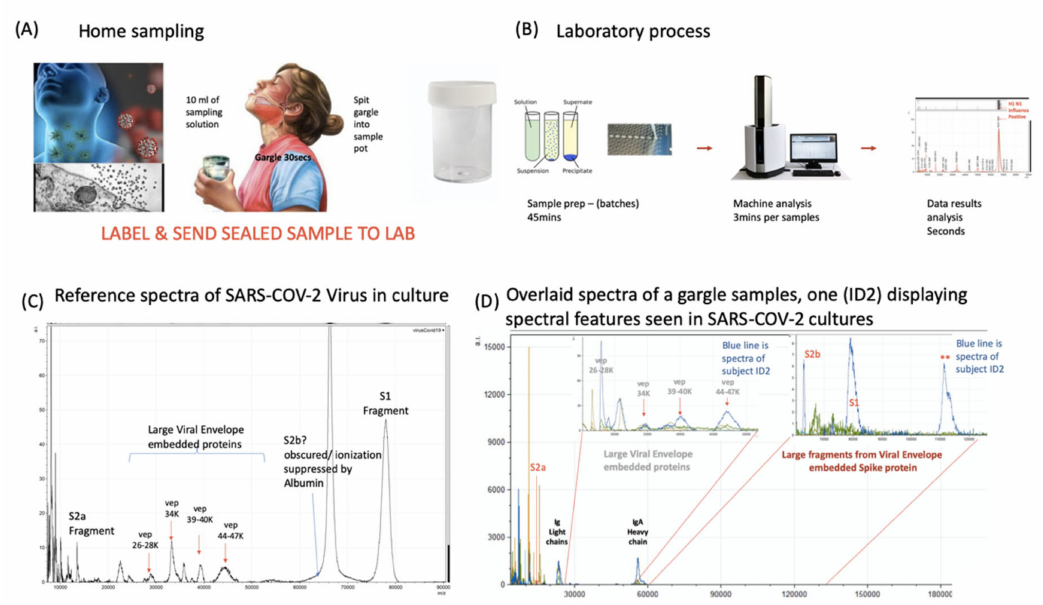
Figure 4. Clinical diagnostic protocol of gargle saliva collection, laboratory processing and spectral data features: Panel ( A ) illustrates patient (home) sampling gargling 10 mL of water and spitting that into a sample pot. Panel ( B ) illustrates rapid processing where received gargle sample is filtered through 1.2 and 0.45 mm filters, 5 mL is recovered and is acetone precipitated. The pellet is resuspended in viral envelope dissolution and protein solubilization bu ff er before being applied to MALDI ToF plates and analyzed (3 min per sample); output data being processed by appropriate software. Panel ( C ) illustrates a reference spectra of SARS-CoV2 grown in vitro with spectral pattern of viral envelope proteins (VEPs) and fragments of coronavirus spike protein labelled. Panel ( D ) illustrates overall spectra of 5 unscreened volunteer samples overlaid. The spectra from subject ID2 is indicated (blue line). Regions corresponding to mass ranges for VEPs and large characteristic fragments of the Spike protein are illustrated. These are illustrated in juxta position to gargle / salivary Immunoglobulin light chain and Ig A heavy chain peaks. Also to note that S2a fragment is surrounded by a host of high intensity / abundance proteins, the origins of which may be a mix of other co-enriched (bacterial) micro-organism from the oral cavity. An additional high molecular mass glyco-protein type peak